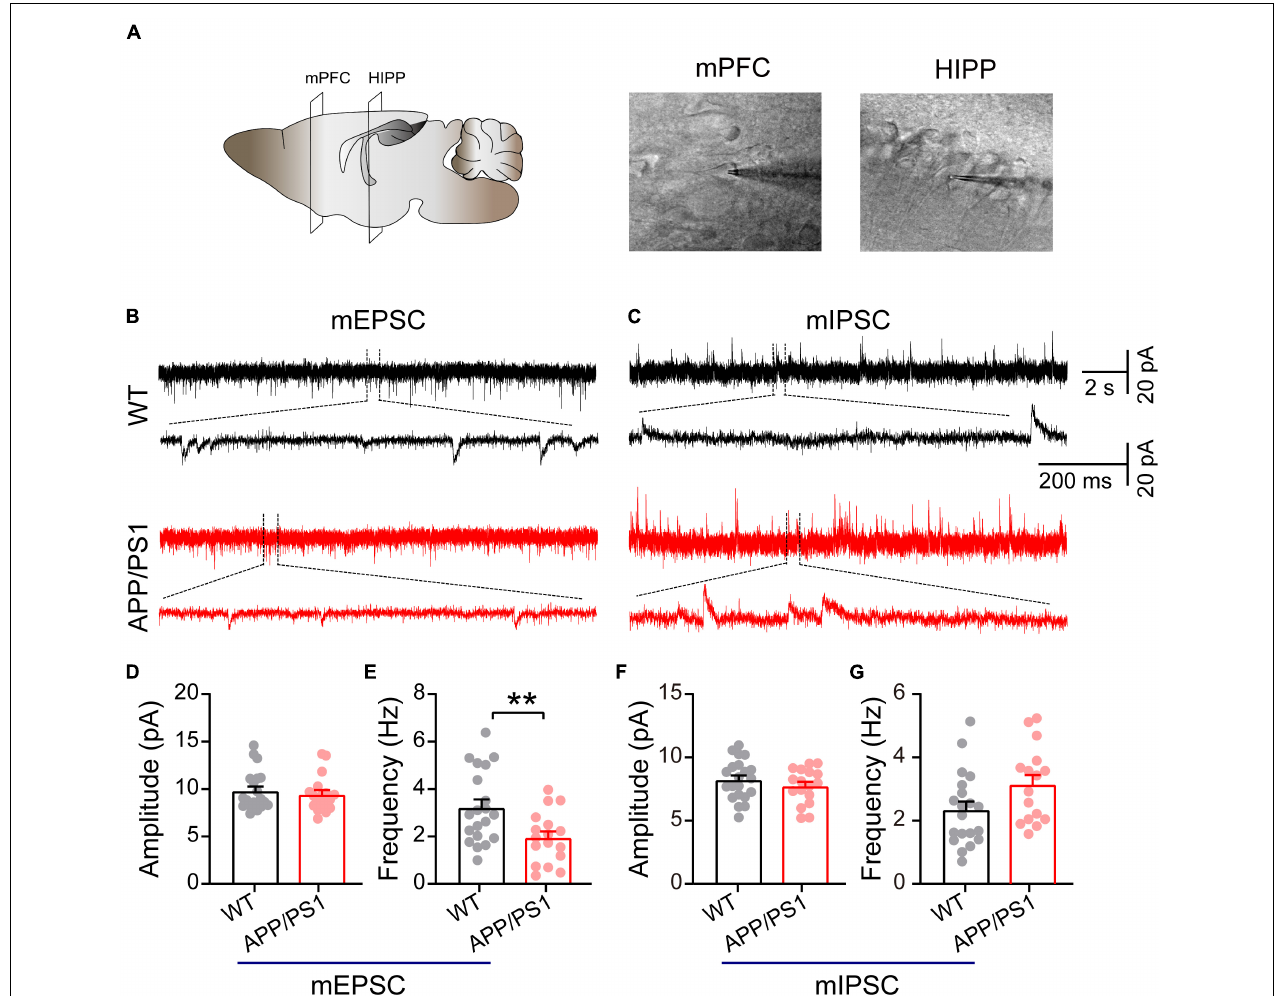
FIGURE 4 | Decreased mEPSC frequency in pyramidal neurons of mPFC in 4 ∼ 5-month-old APP/PS1 mice. (A) Schematic of the mPFC and HIPP pyramidal neuron where whole-cell patch-clamp recording was performed. (B) Representative mEPSC and (C) mIPSC traces recorded in the mPFC. (D,E) Statistical analysis indicating significantly increased frequency but not amplitude of mEPSCs in APP/PS1 mice (frequency: p = 0.0072; amplitude: p = 0.5751; WT: n = 20 cells of 6 mice; APP/PS1: n = 17 cells of 6 mice). (F,G) Identical mIPSC frequency and amplitude in APP/PS1 mice (frequency: p = 0.0512; amplitude: p = 0.3179; WT: n = 21 cells of 6 mice; APP/PS1: n = 17 cells of 6 mice; two-sample t -test). Each value represents the mean ± SEM; ** p < 0.01.